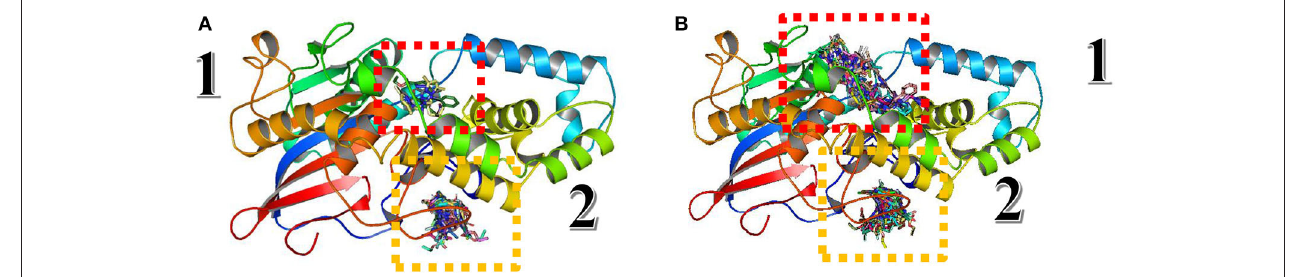
FIGURE 14 | Blind docking/virtual screening of Fophy protein using Autodock Vina (A) and Dockthor (B)